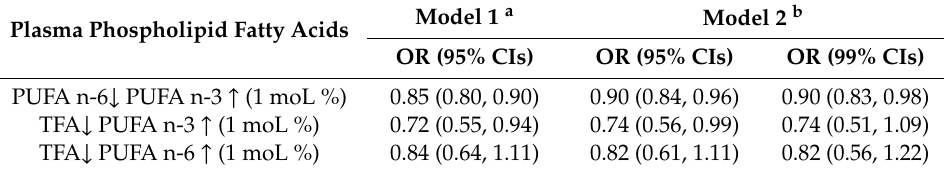
Table 4. Odds ratios (95% CIs) of CHD associated with 1 moL % substitutions between